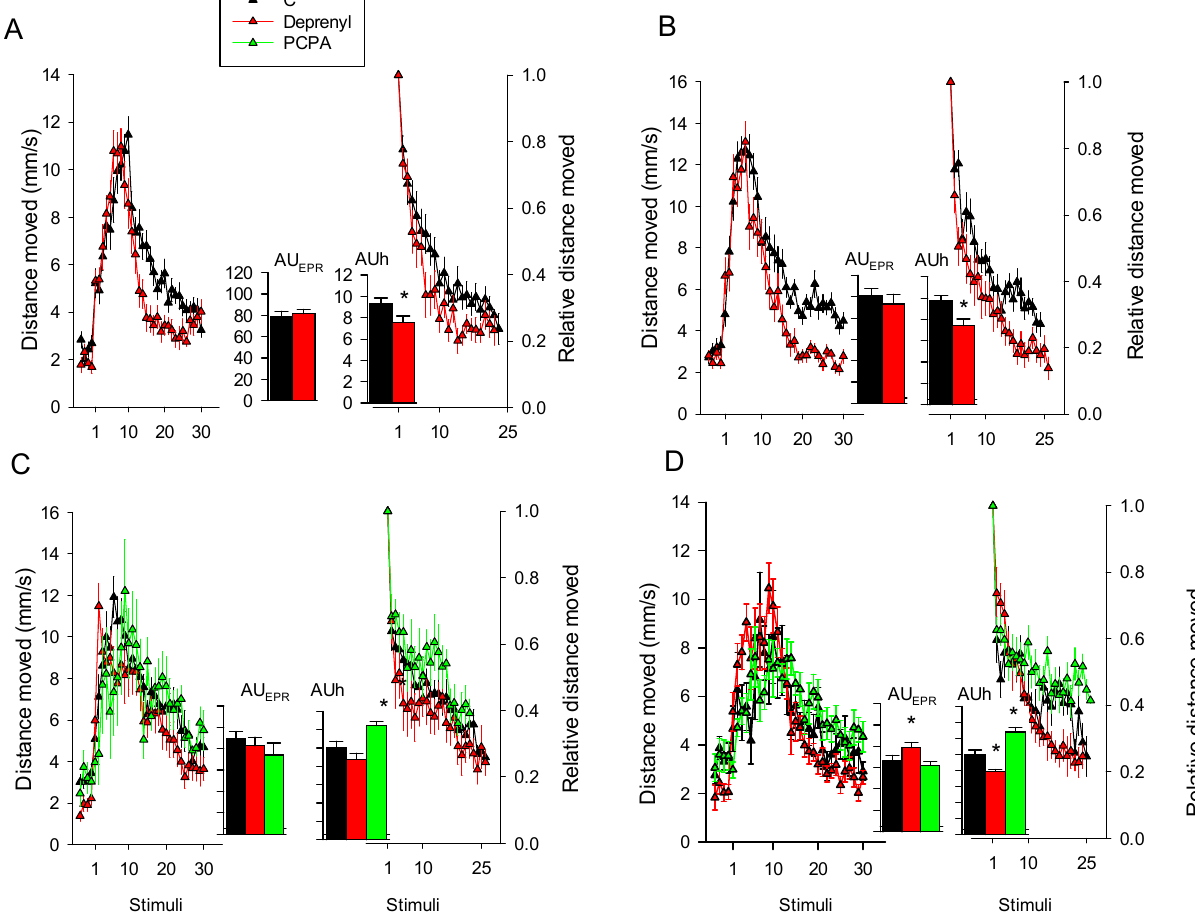
Figure 1. Daphnia photomotor responses to repetitive light stimuli following 24 h exposures to 1 and 10 mg/L of deprenyl and PCPA, respectively. Plots of the average distance moved ± SE ( n = 12–24) against 30 tapping stimuli at 5 s ISI and corresponding bar charts (graph inlet) of the calculated area under the curve (mean ± SE) for EPR (AUC EPR ) and habituation AUCh phases. Within each of the four graphs, the left plots represent the full motile responses whereas the right ones show habituation responses measuring the decrease in the distance moved (proportions) relative to the maximum response to the light stimulus delivered (set to 1). Graphs ( A , B ) depict the data obtained across two independent experiments for deprenyl exposures, ( C , D )—for deprenyl and PCPA exposures. Within the AUC bar graphs, * means significant ( p < 0.05) treatment differeces relative to the controls following the Student’s t -test or ANOVA and Dunnett’s test. Axis scales for the AUC (graph inlet) are depicted in graph ( A